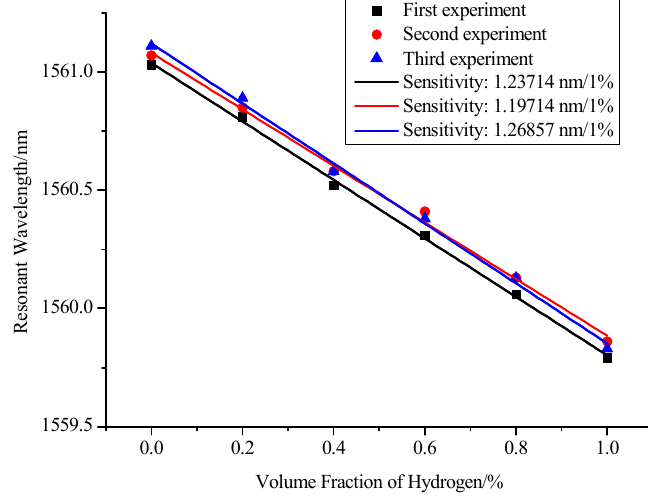
Figure 10. Repeatability curve of the proposed hydrogen sensor.